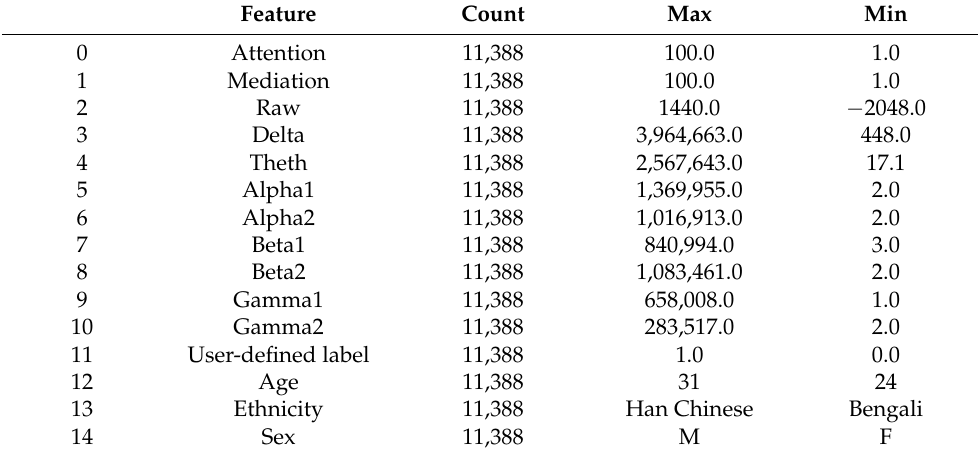
Table 1. EEG data set.